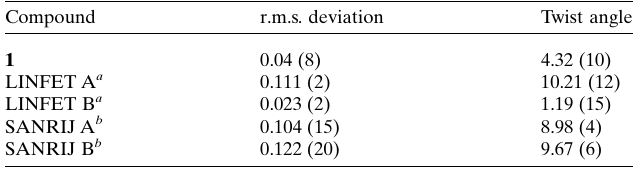
Table 2 r. m. s. deviations and twist (A˚ , (cid:4) ) angles. The twist angle is the dihedral angle between the five-membered heterocycle and the keto-aromatic plane. Compound